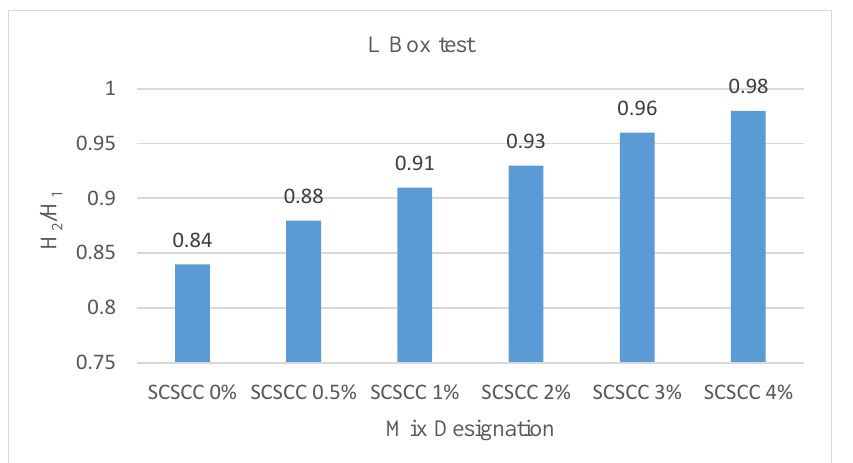
Fig. 13. Results of L Box test for